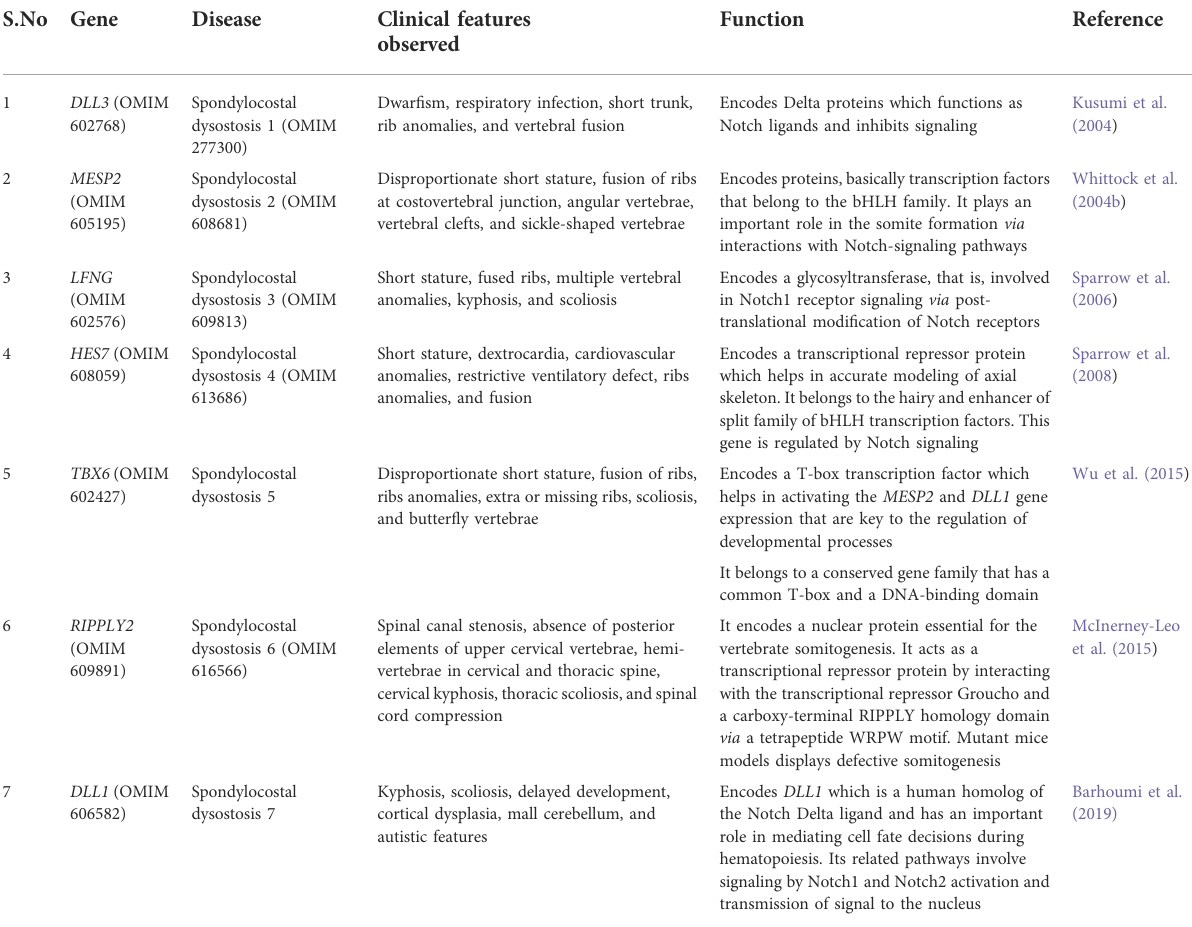
TABLE 1 Spondylocostal dysostosis-associated genes, associated clinical representation, and function in the Notch-signaling pathway. S.No